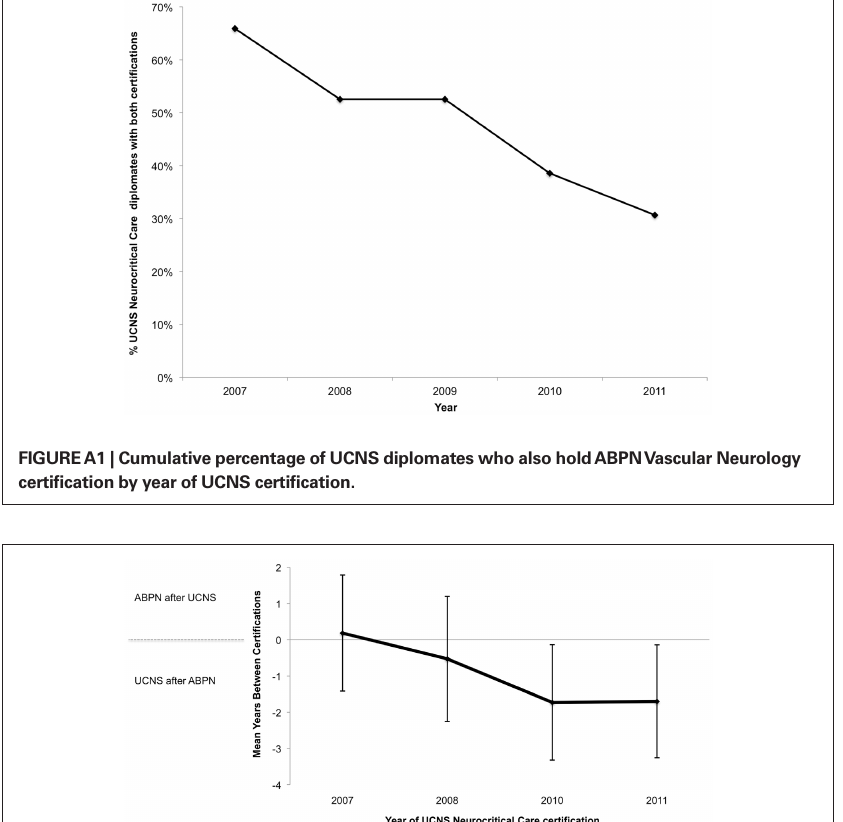
Figure A2 | Average number of years between receiving each certification in individuals with both certifications listed by year of uCNS certification. For each individual, the difference is calculated as year of ABPN certification minus year of UCNS certification. Error bars are ±1 SD.